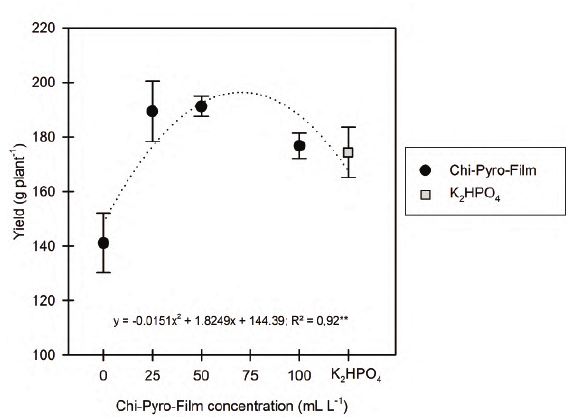
Fig. 4 ­ Yield of strawberry, in response to Chi­Pyro­Film concen­ trations and reference treatment (K Isolated effect of film concentration (average of cultivars responses). *, **, ***, significant at p<0,05, p<0,01, p<0,001, respectively.